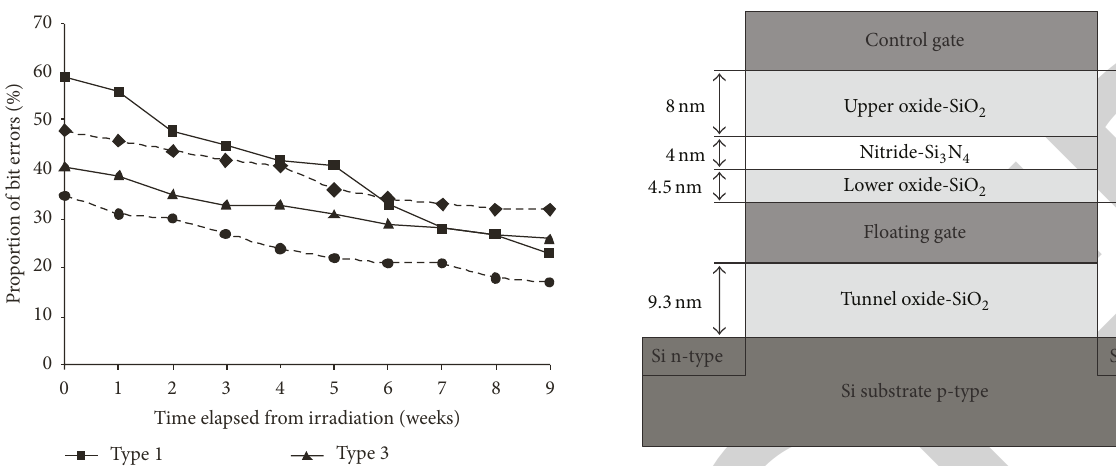
Figure 5: Model of the flash memory cell used in the numerical simulation of the ions passage.